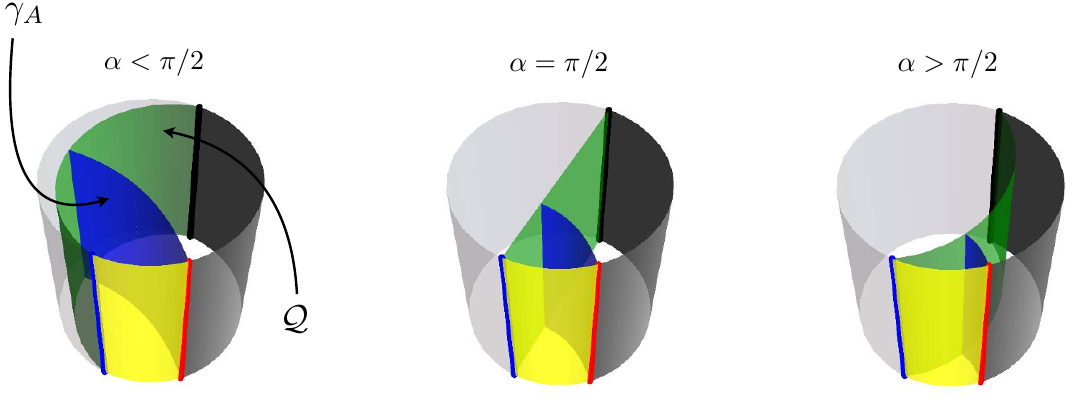
Figure 29 . The spacetime (F.60), whose boundary is the union of the surface in (cid:12)gure 28 and of the green surface Q in (F.63), which depends on the parameter (cid:11) 2 (0 ; (cid:25) ). The blue surface is the minimal area surface ^ (cid:13) A corresponding to the in(cid:12)nite strip adjacent to the boundary (yellow region). The parameter (cid:11) changes in the various panels: (cid:11) = (cid:25)= 10 (left), (cid:11) = (cid:25)= 2 (middle) and (cid:11) = 3 (cid:25)= 4